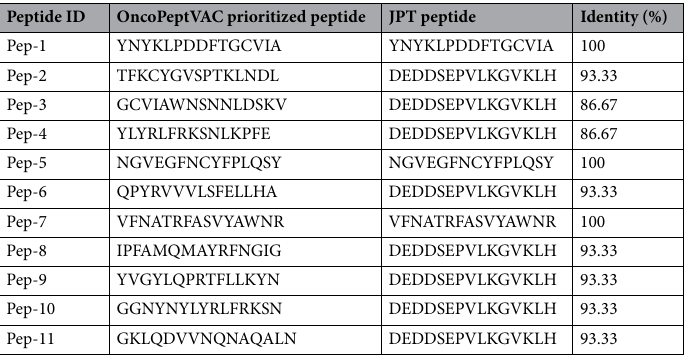
Table 2. Identity of OncoPeptVAC prioritized peptides to the commercially available peptide pools.